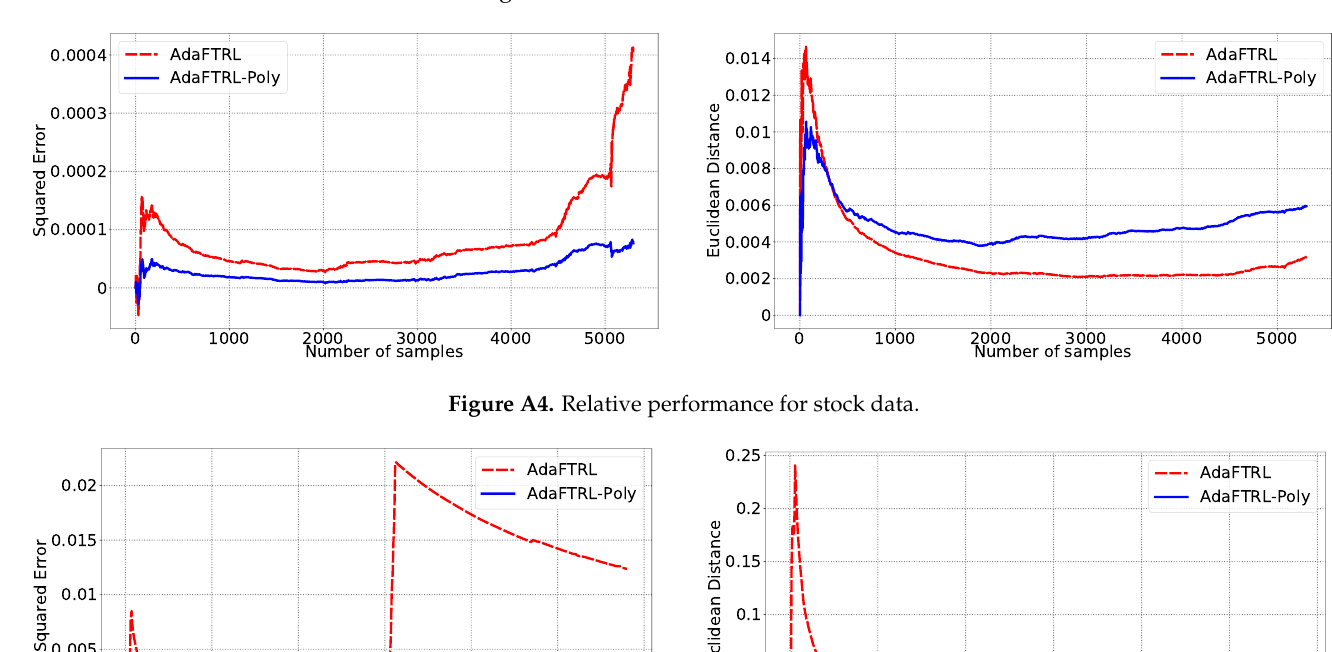
Figure A3. Relative performance for setting 3. Similarly, we plot the relative performance for the real-world data over the time horizon in Figures A4–A6.